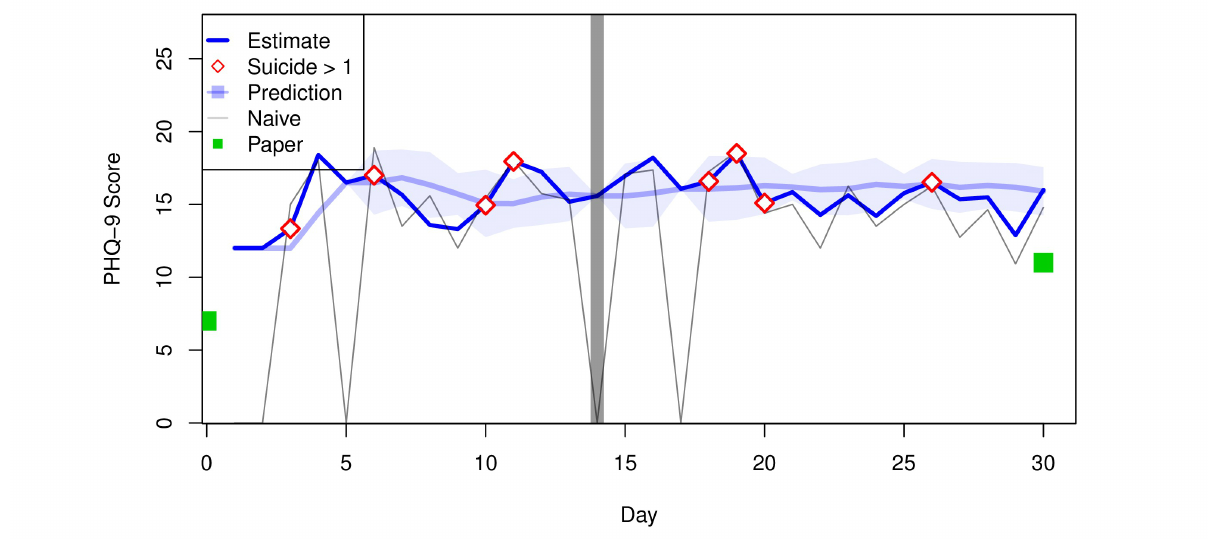
Figure 4. PHQ-9 estimates, reported suicidal thoughts, predictions, confidence intervals, naïve scores, and paper scores for Subject 1. Significant suicidal thoughts (Likert score >1) are shown as red diamonds. The green squares correspond to paper-based PHQ-9 scores. A horizontal line is included after the first 2 weeks.